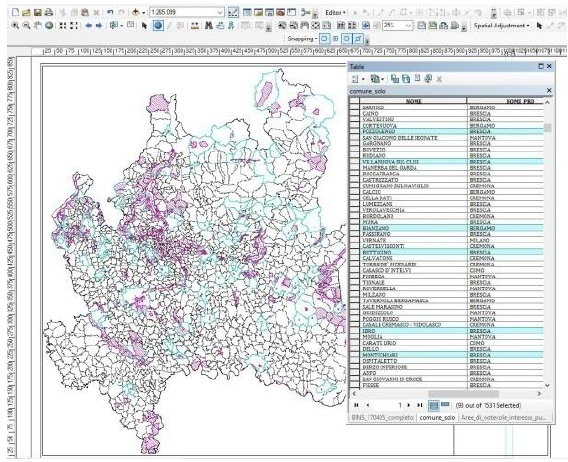
Figure 6. Lombardy PPR review: identification (in light blue) of the Lombardy municipalities with landscape preservation binding action at National level concerning the entirely municipal territory.